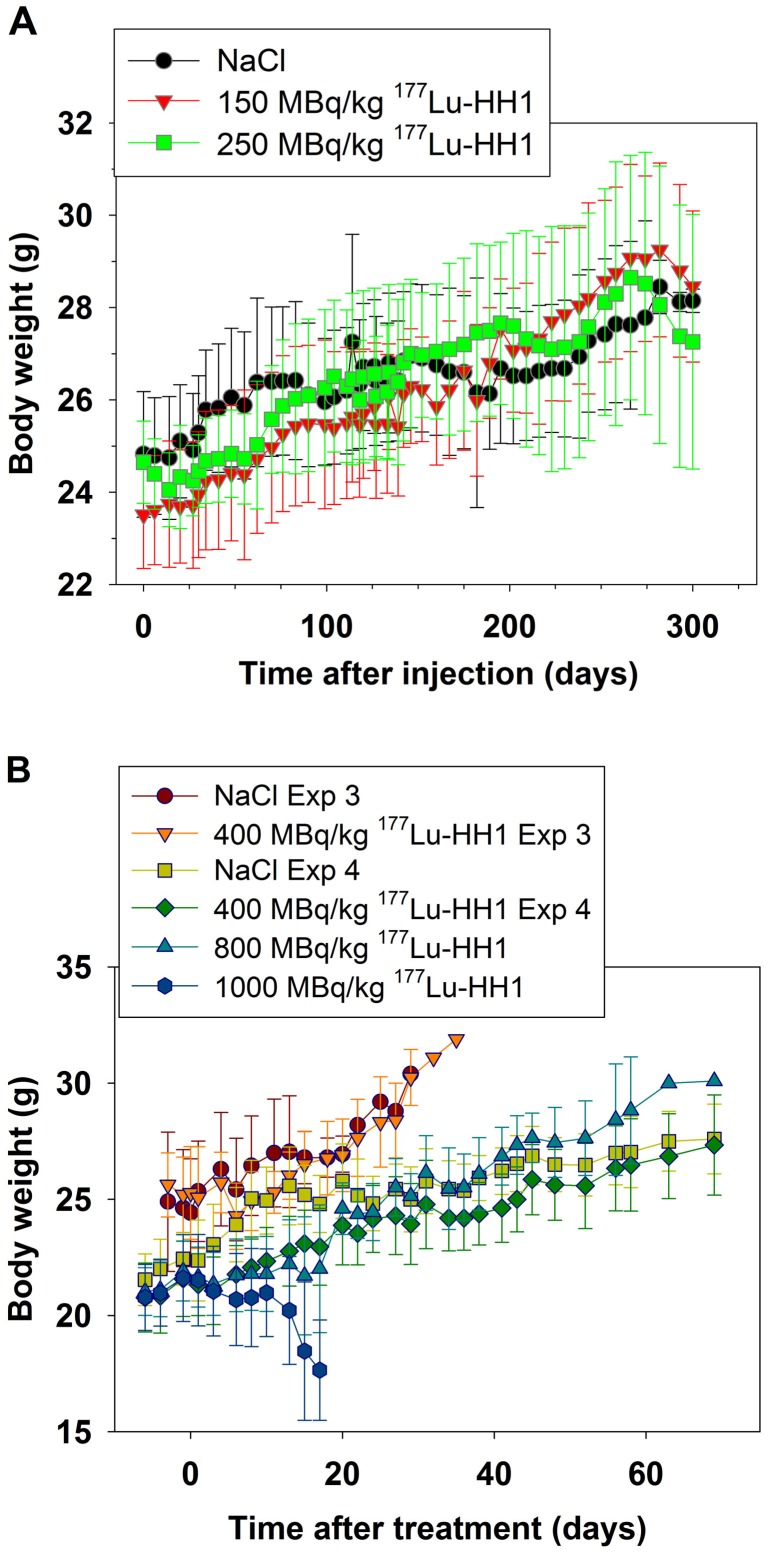
Effects of increasing dosages of 177Lu-HH1 on bodyweight of nude mice.Error bars  =  SD, N = 4–10. A. Mice without xenografts treated with saline, 150 or 250 MBq/kg 177Lu-HH1 (experiment 2). B. Mice with Ramos xenografts treated with saline or 400, 800 or 1000 MBq/kg 177Lu-HH1 (experiment 3 and 4).